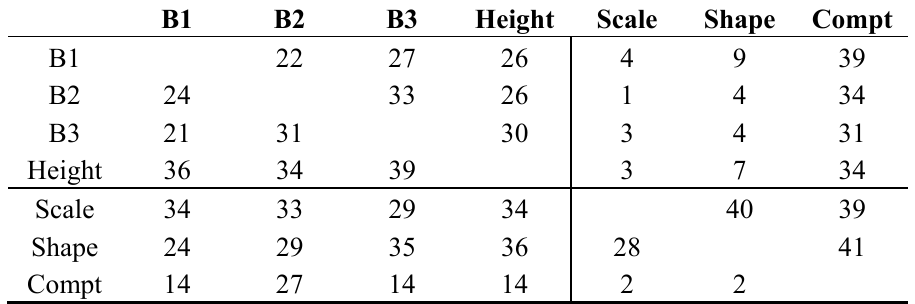
Table 9. Parameter domain interdependency test over 100 runs for the MS segmentation algorithm and Spectral Split transform on the Bokolmanyo site using the RWJ